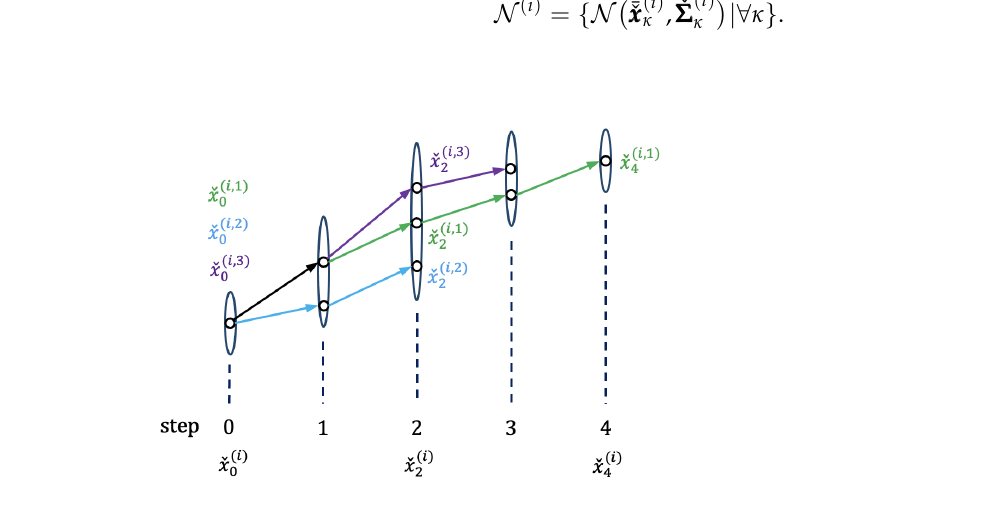
Figure 4. A set of Gaussian distributions representing the motion pattern which is the output of intention-pattern